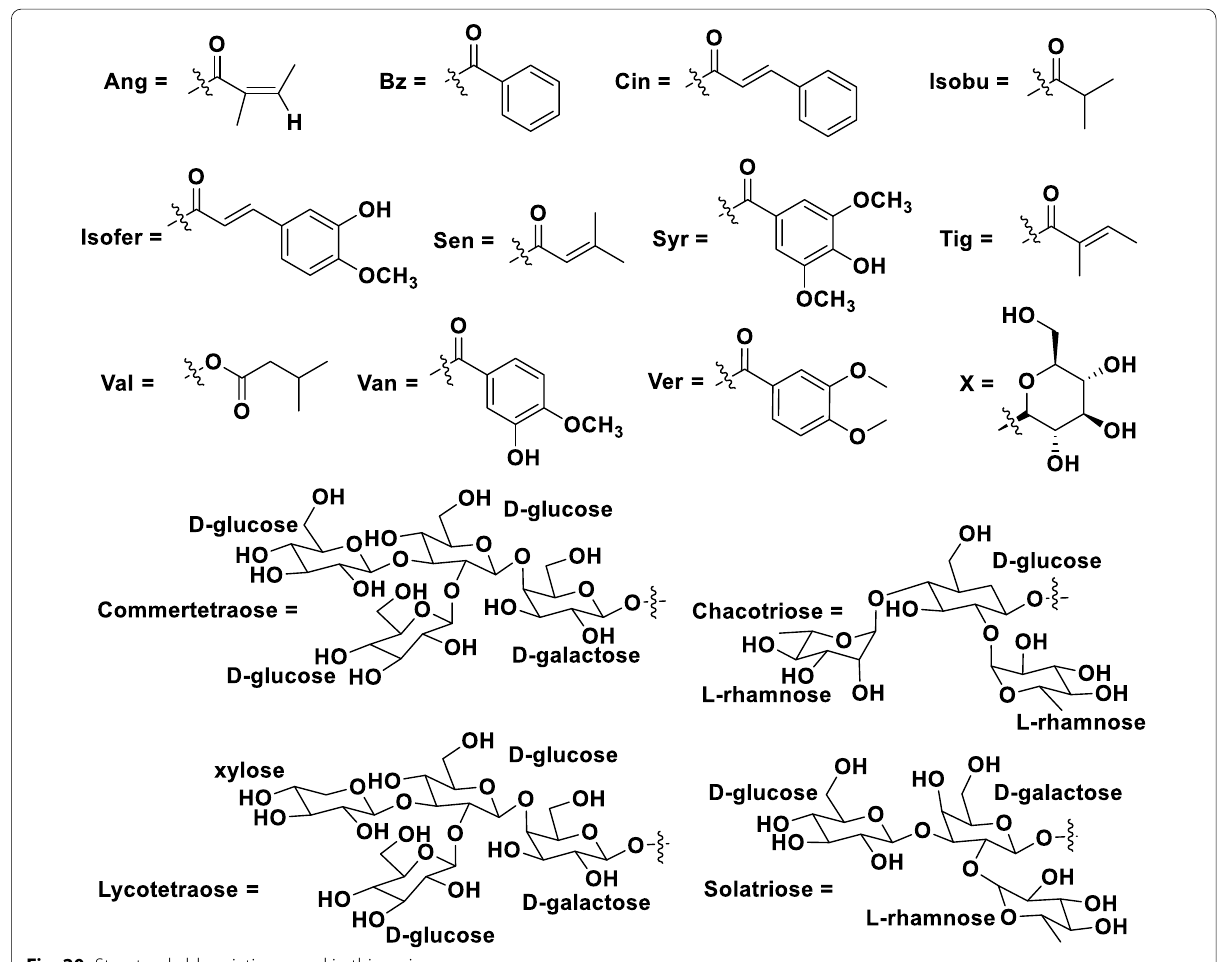
Fig. 20 Structural abbreviations used in this